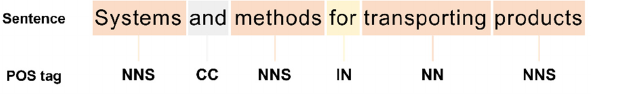
Figure 7. Example of POS tagging.